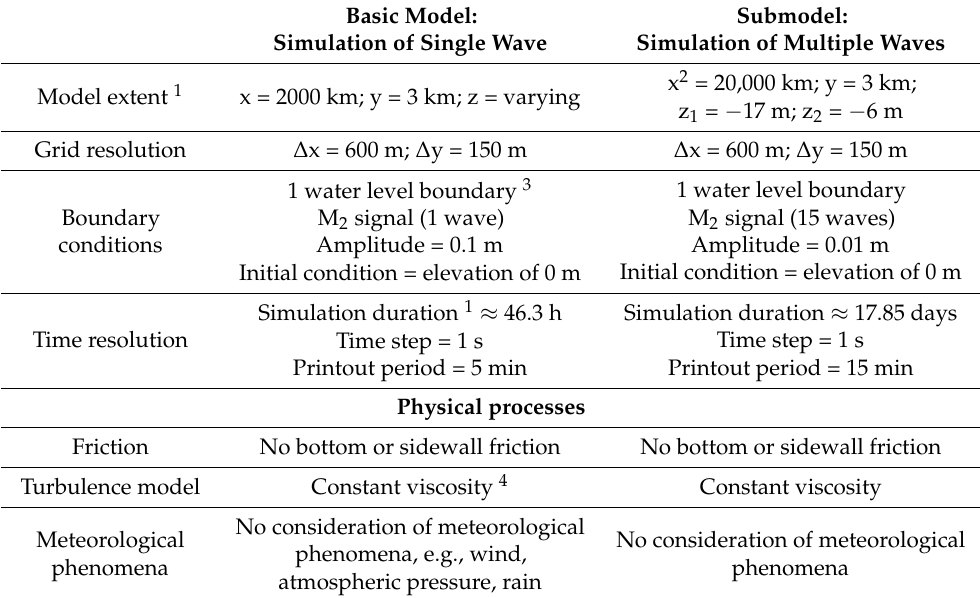
Table 1. Overview of model extent and simulation